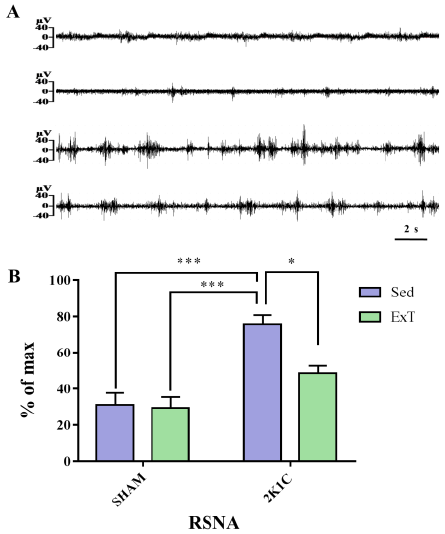
Figure 2. The effect of eight-week of aerobic ExT on RSNA. (A) The schematic diagram of RSNA. (B) Statistical analysis of the level of RSNA. * p < 0.05, *** p < 0.001, n = 4.